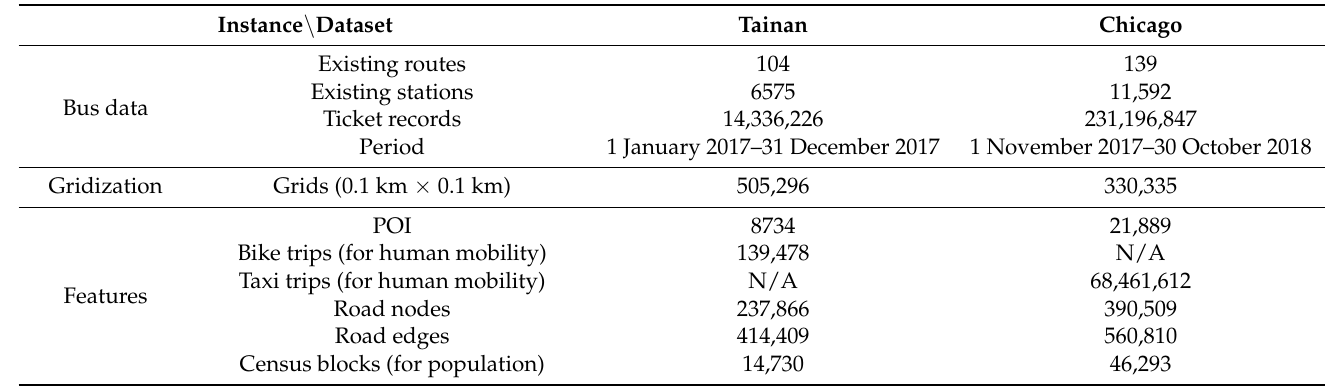
Table 2. Size figures for our input